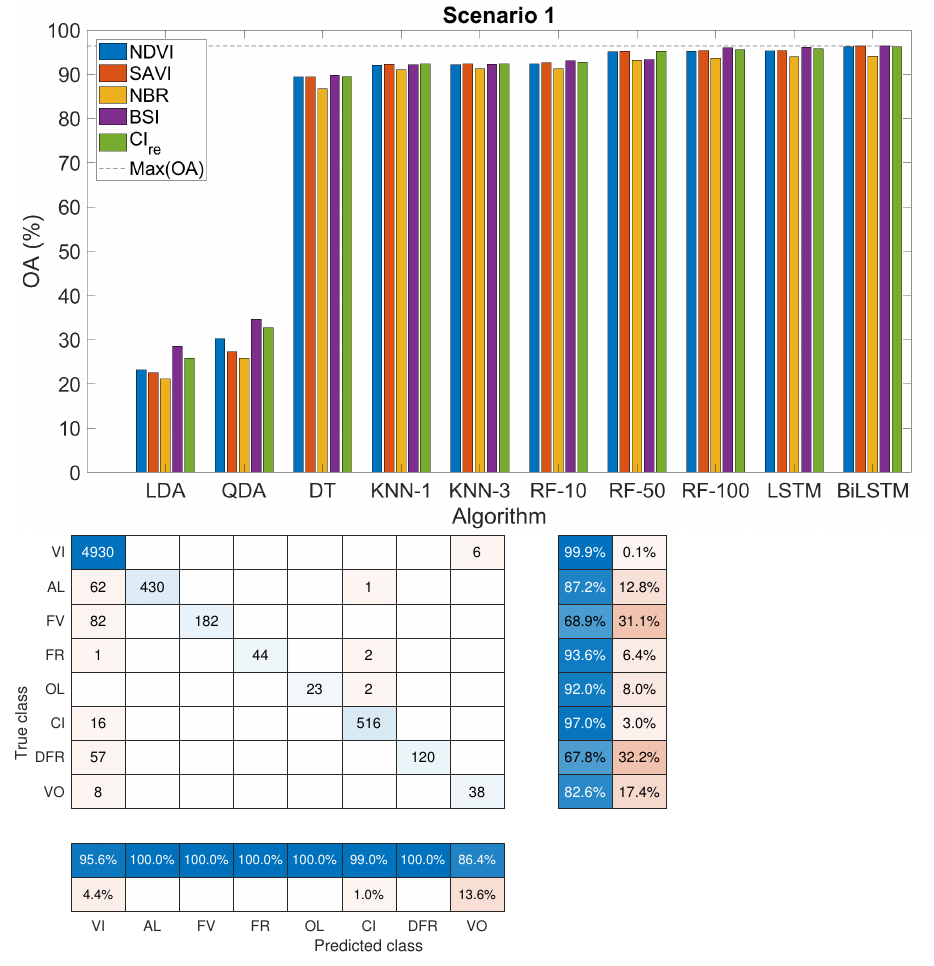
Figure 4. Results for the scenario 1: ( top ), accuracies. ( bottom ), confusion matrix of best model (2-BiLSTM trained with the BSI dataset).